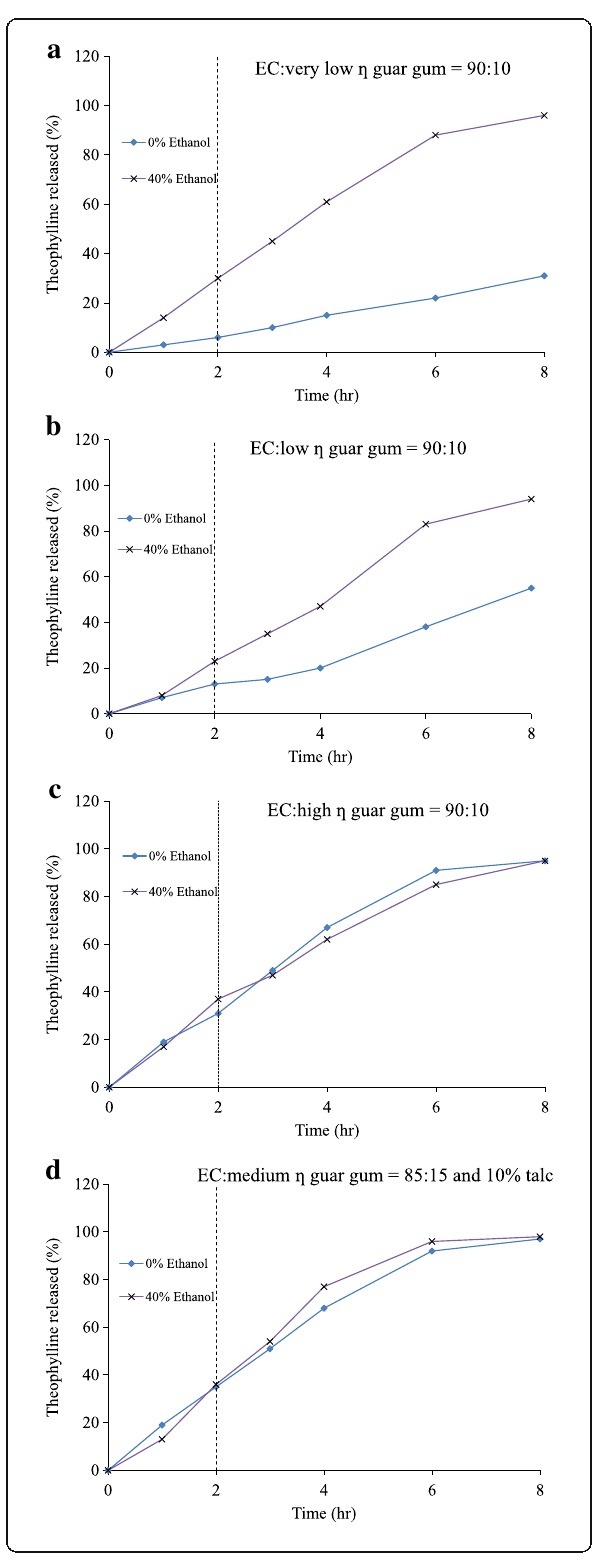
Fig. 17 Effect of ethanol on release of theophylline from pH 7.4 phosphate buffer ( dotted line indicates a change from acid to buffered non-ethanolic conditions) (data from reference (Rosiaux et al. 2013))